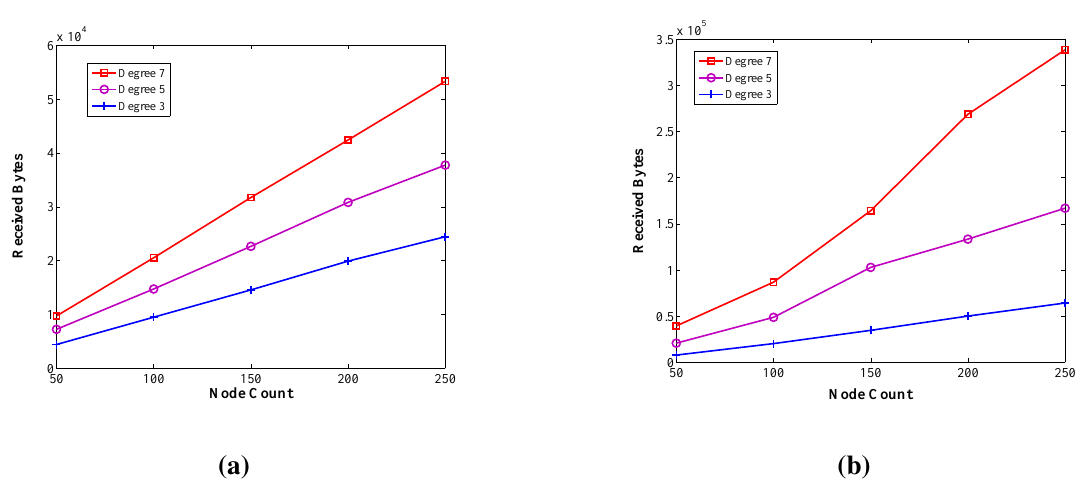
Figure 14. Received bytes of ABIDE and E-MILIC algorithms against node count and degree. ( a ) Received bytes of ABIDE; ( b ) received bytes of E-MILIC.